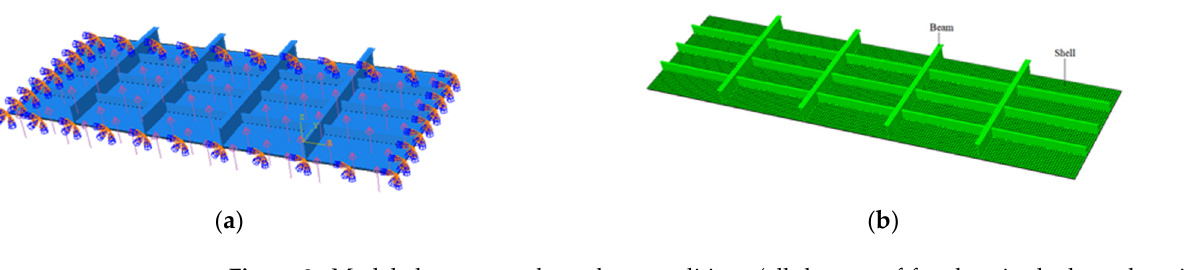
Figure 9. Modeled geometry, boundary conditions (all degrees of freedom in the boundary, i.e., connection with transverse beams) and uniformly distributed pressure load (with direction upwards) ( a ) and corresponding mesh for the cross-stiffened panel ( b ). The stiffeners’ cross-sections are presented for rendering purposes.Figure 10 presents the normal bending stress along each stiff- ener direction for two different modeled cases. It is evident that the mid-stiffener attained a sym- metric stress field along its span (between two neighboring transverse stiffeners). The effect of the model extent (number of longitudinal and transverse stiffeners) and peripheral supports do not in- fluence the target stiffener considered for post-calculations.